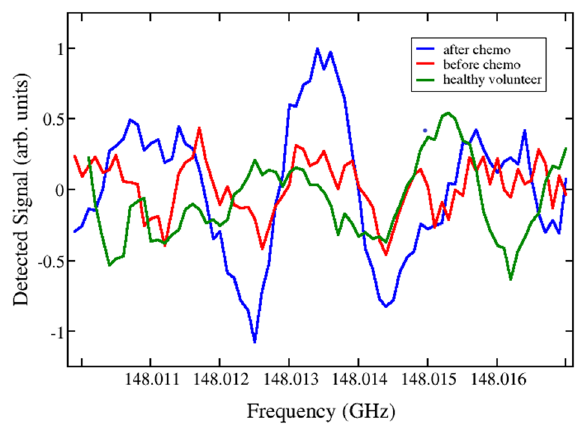
Figure 3. Experimental detection of the absorption spectral line of ethanethiol (a-C2H5SH) measured in the sample of patient 2 before (solid, red) and after chemotherapy (solid, blue), compared with the corresponding reference measurement for healthy volunteer 1 (dashed, green). There are two quantum transitions near this frequency at f = 148.0132725 GHz, characterized in the databases 31,32 by Lg I = − 5.5024 and quantum numbers